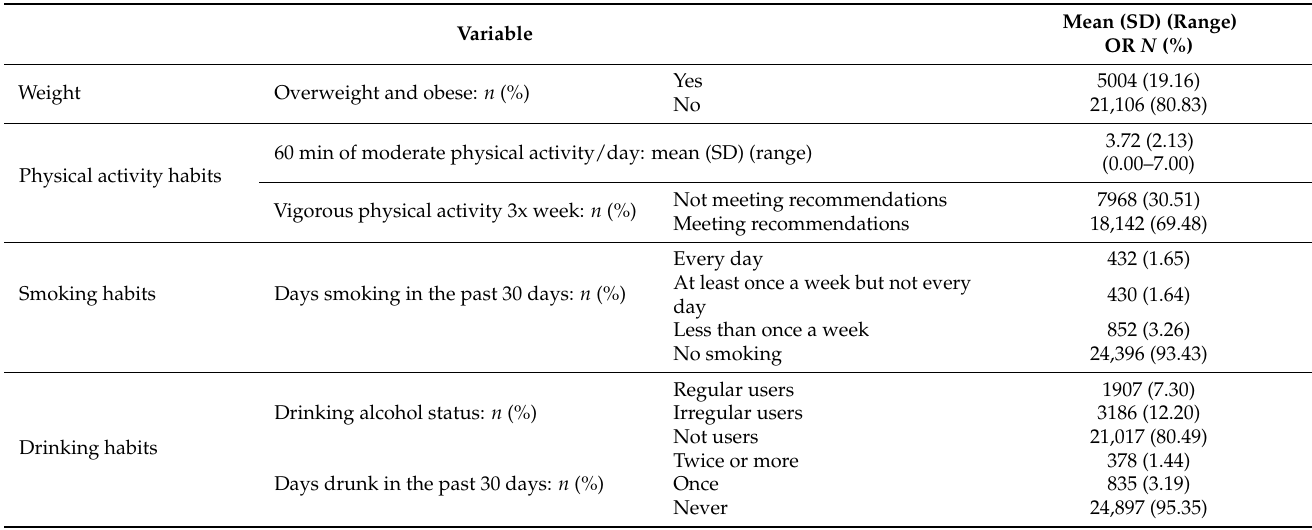
Table 2. Lifestyle characteristics of the study sample ( n =